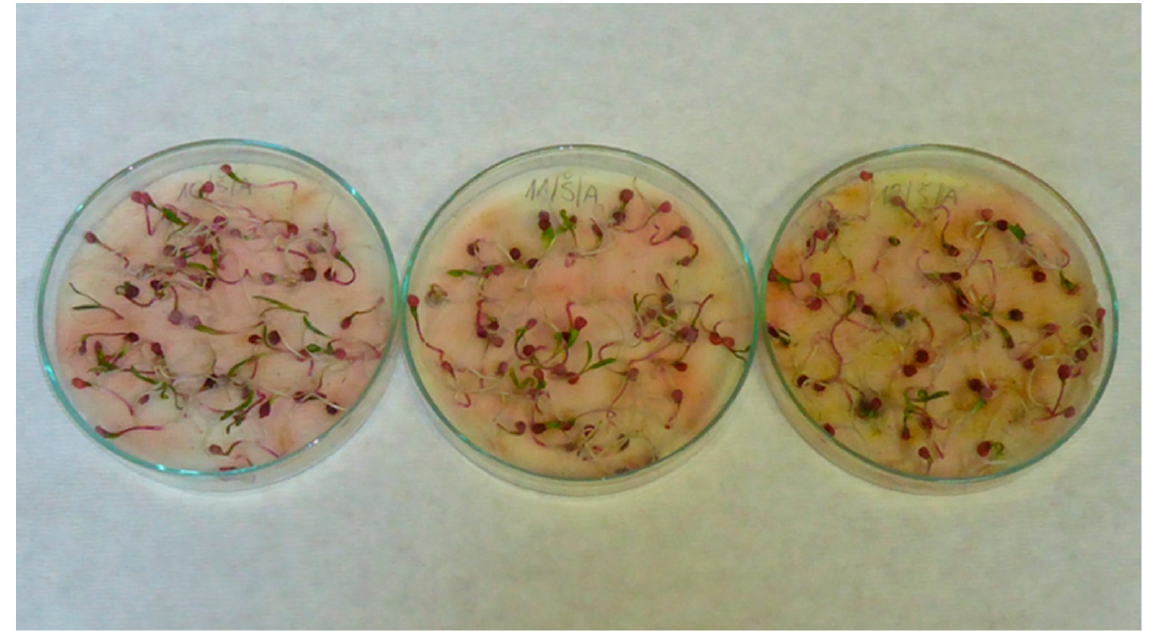
Appl. Sci. 2023 , 13 , x FOR PEER REVIEW Figure A5. Spinach ( Spinacia oleracea L.) seedlings; treatments with aqueous extracts of chia ( Salvia hispanica L.) in 2.5% concentration ( left ), 5% concentration ( middle ) and 10% concentration ( right ).